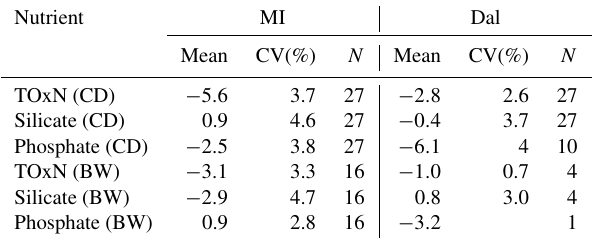
Table 6. Mean differences from certified values, and coefficients of variation of the differences (CV(%)) for the KANSO CRMs anal- ysed by the Marine Institute (MI) and Dalhousie University (Dal). The CV(%) were calculated as the (standard deviation / mean × 100%). The KANSO batches CD and BW were used by both groups, where N is the number of measurements. Dal results for phosphate do not include analyses prior to Station 46 (see